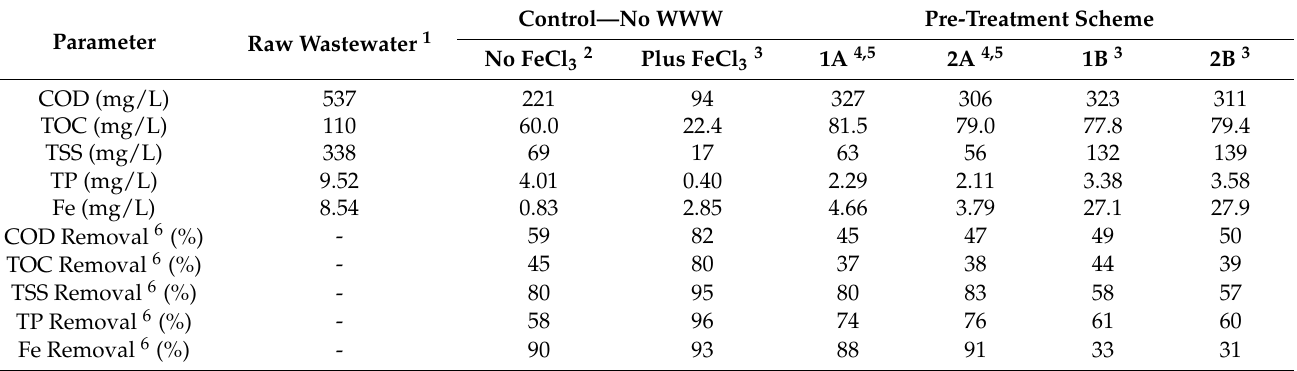
Table 5. Simulated primary effluent concentrations and removal rates for actual domestic WWTP raw influent plus WWW after undergoing various types of